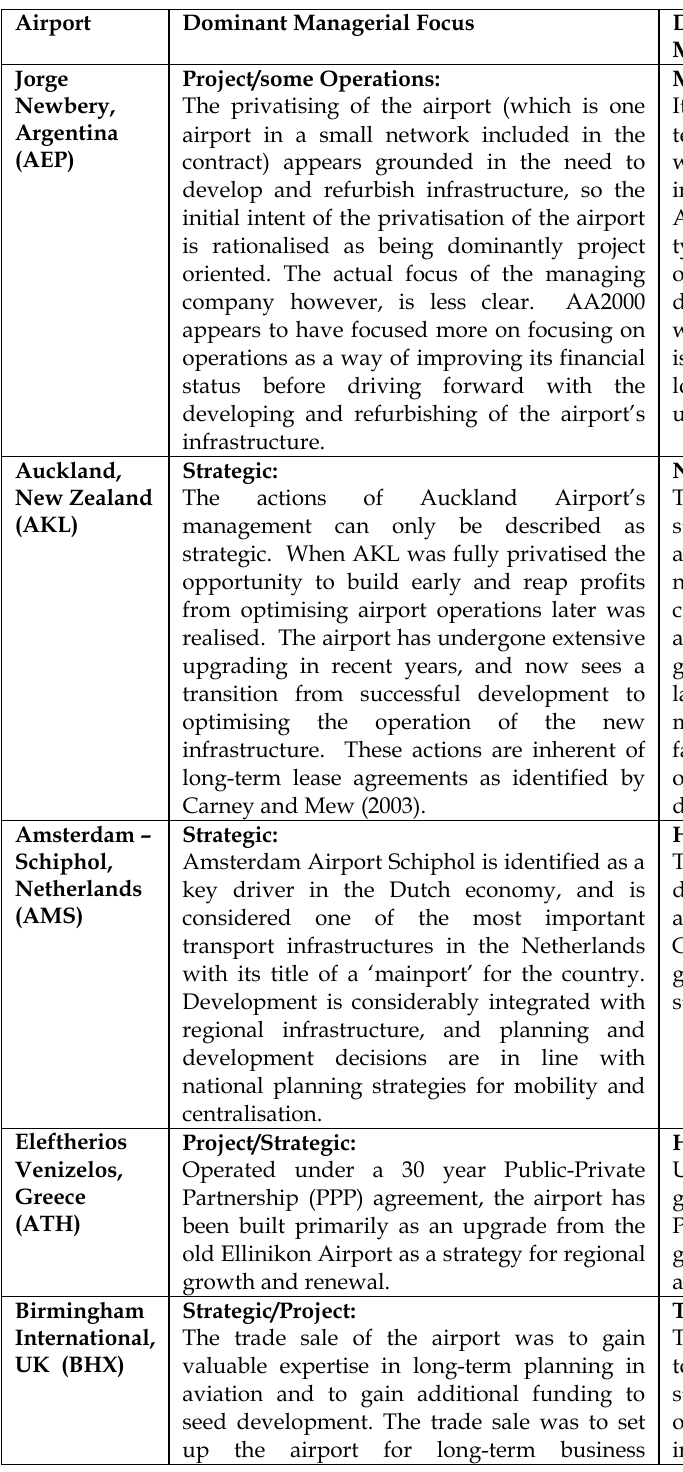
Table 3. Interpreted airport